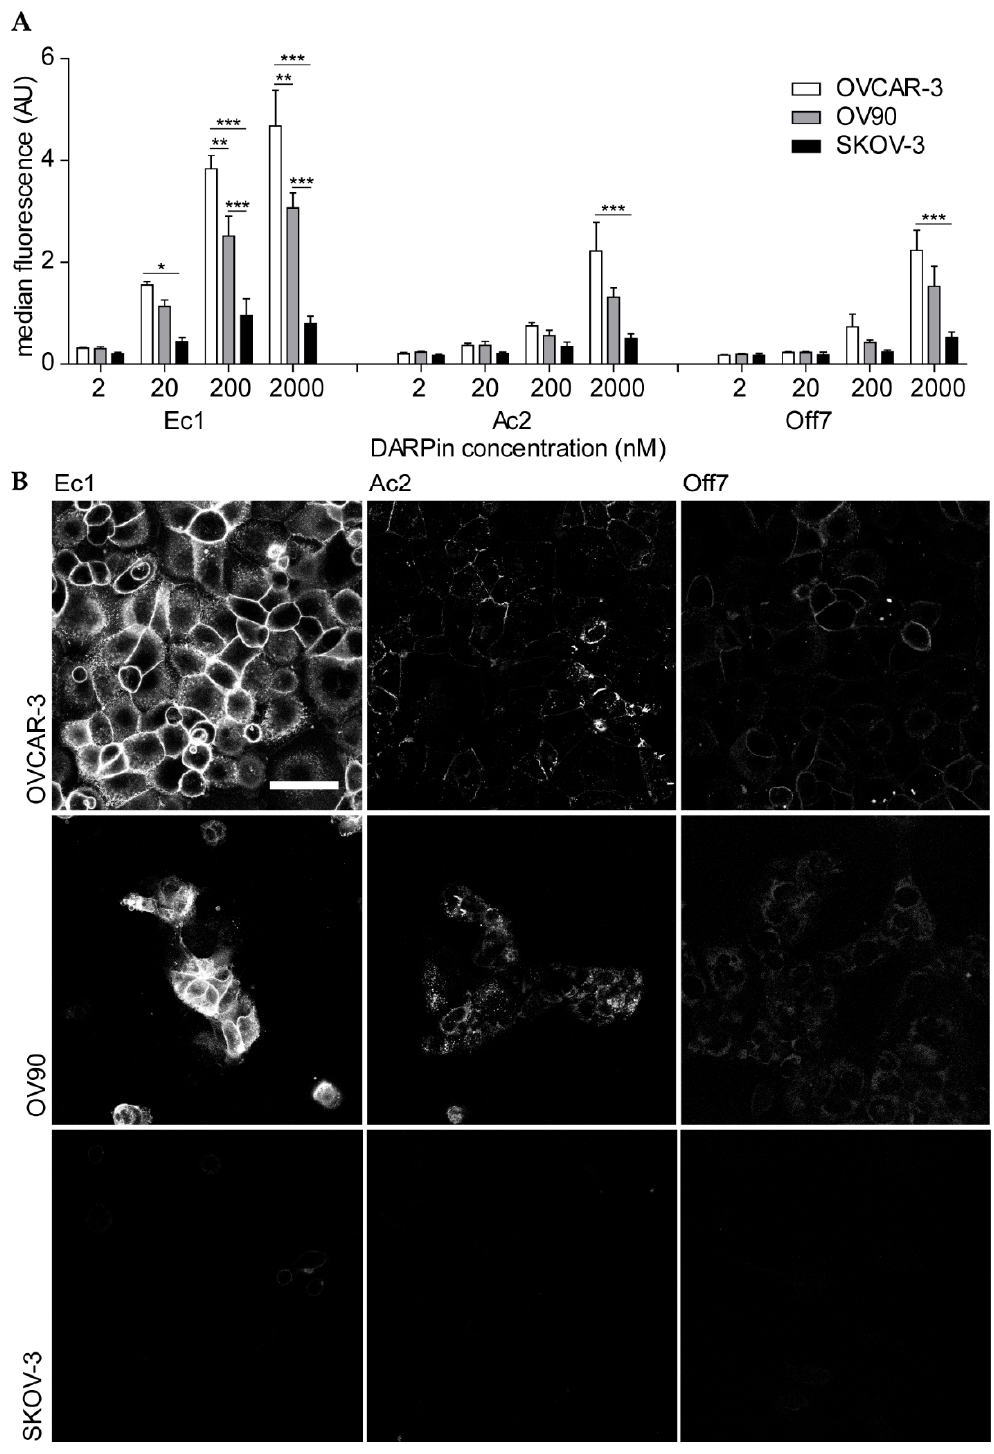
Figure 2. Binding of DARPin-fluorescein conjugates to ovarian cancer cell lines. ( A ) Flow cytometry of cells that were incubated with di ff erent concentrations of DARPins. Mean ± s.e.m. is shown. A two-way ANOVA with Bonferroni post hoc test was used to calculate statistical di ff erences. * p < 0.05, ** p < 0.01, *** p < 0.001. OVCAR-3 n = 5; OV90, SKOV-3 n = 3. ( B ) Confocal microscopy images of cells that were incubated with 200 nM DARPin-fluorescein conjugates. Laser power and gain were kept constant and brightness and contrast settings were adjusted equally. Scale bar represents 50 µ m; n = 3; data from a representative experiment are shown. 2.3. Phototoxicity of DARPin-IRDye 700DX Conjugates in 2D and 3D Cell Cultures